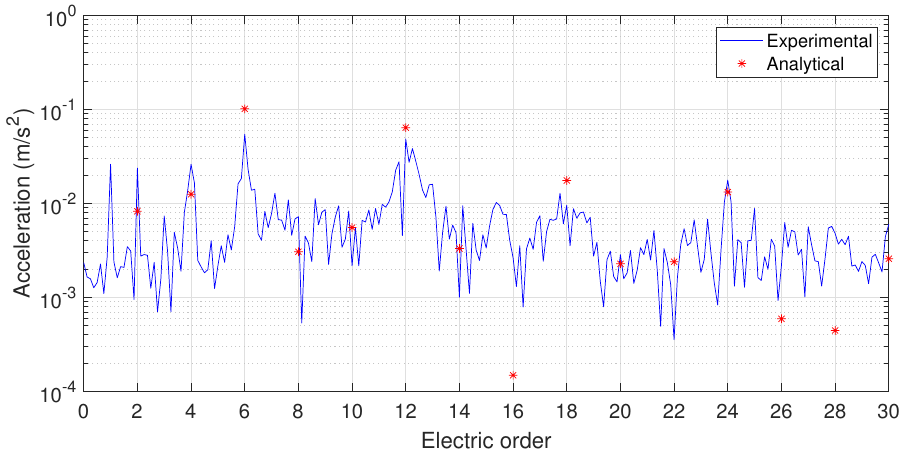
Figure 10. Comparison of the vibration response of the machine with 48 slots and 8 pole pairs. In addition, the machines of 48 slots and 8 pole pairs, and of 18 slots and 8 pole pairs are compared in Figure 11. The predominant harmonics can be clearly observed in each case: the 6th harmonic for the 48p8, which corresponds to the mode order 0 due to a low LCM value, and the 2nd harmonic for the 18p8 due to the low GCD value (see Table 6).